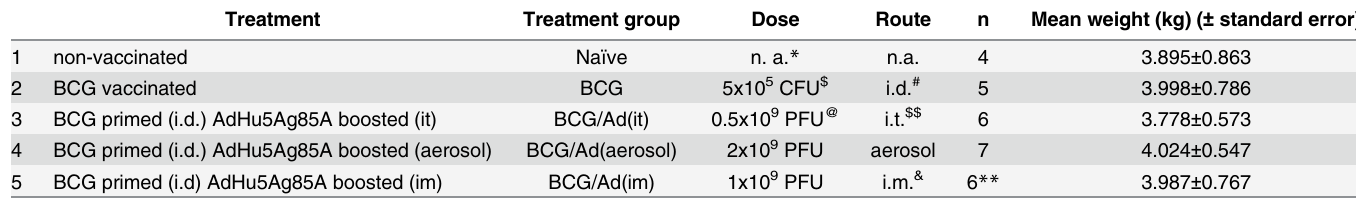
Table 1. Characteristics of treatment